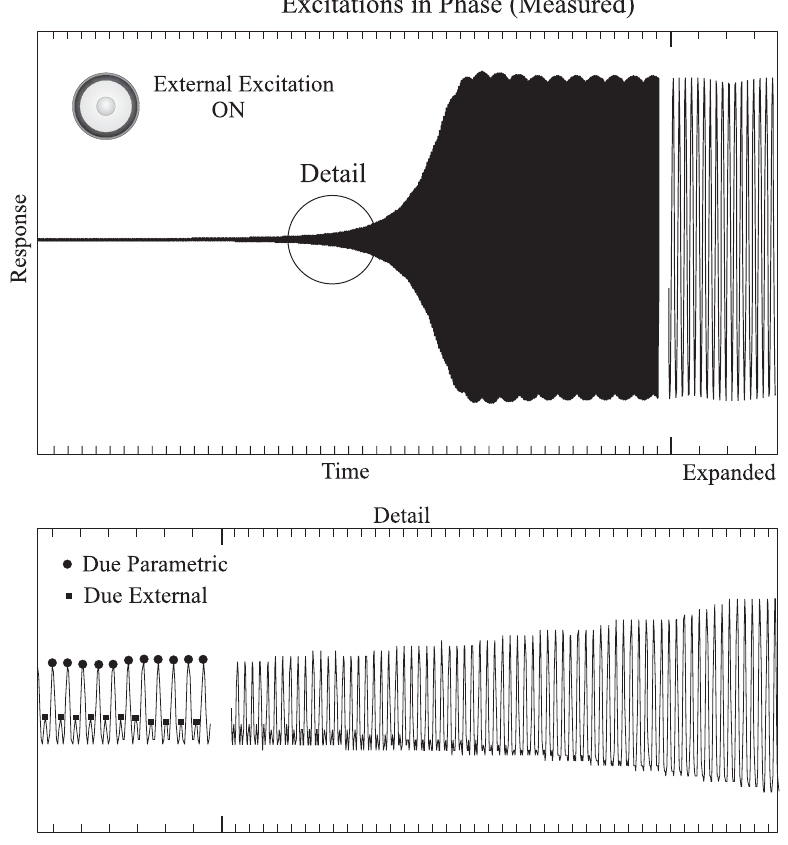
Fig. 14. Measured time-history, with the effects of combined parametric and external excitations, both in